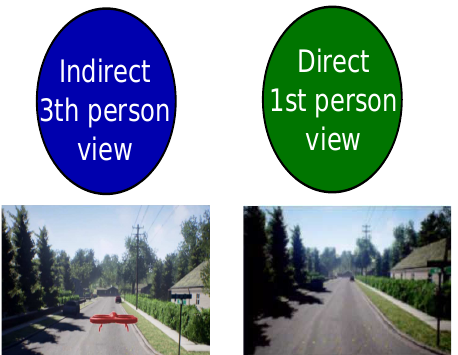
Figure 2. Direct and indirect approaches for the path-planning